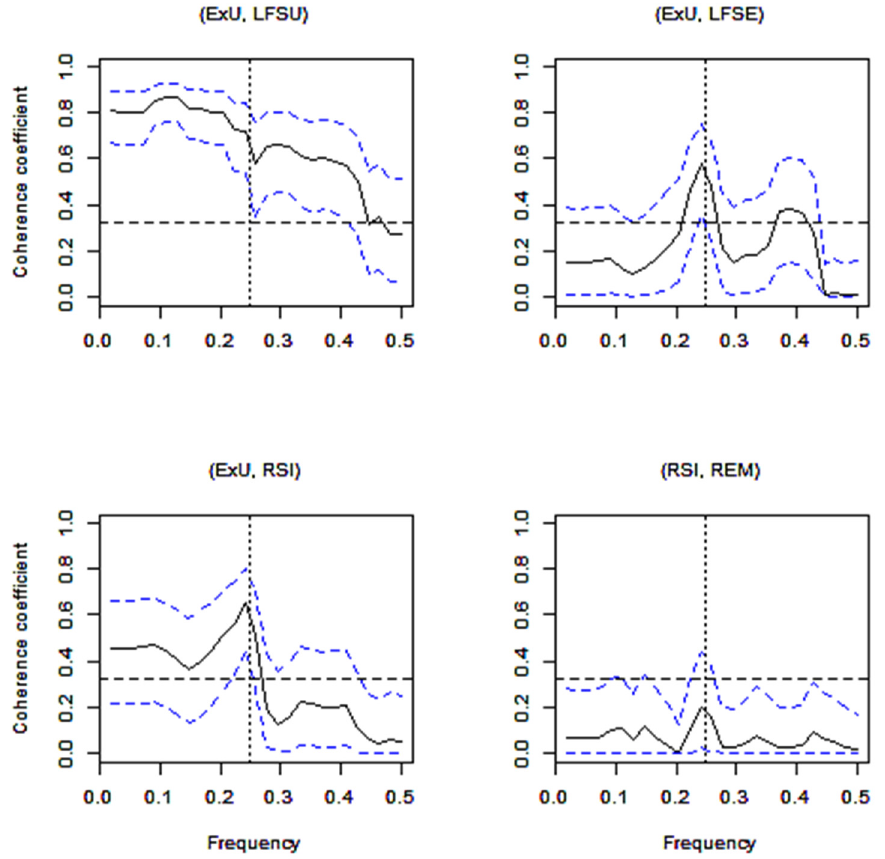
Figure 5. Visualisations of coherence coefficients (in black) and their 0.95-level confidence interval (in blue).